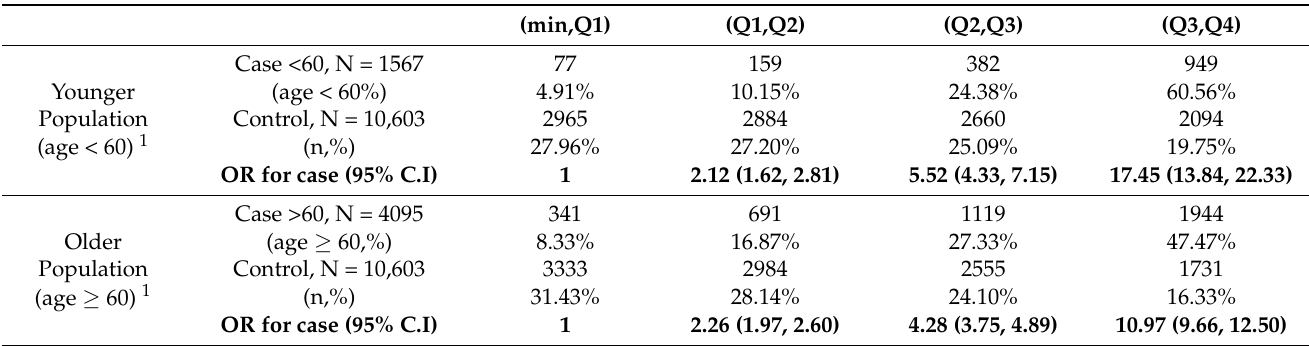
Table 4. Distribution of cataract cases and controls regarding PRS quantiles in younger and older groups.